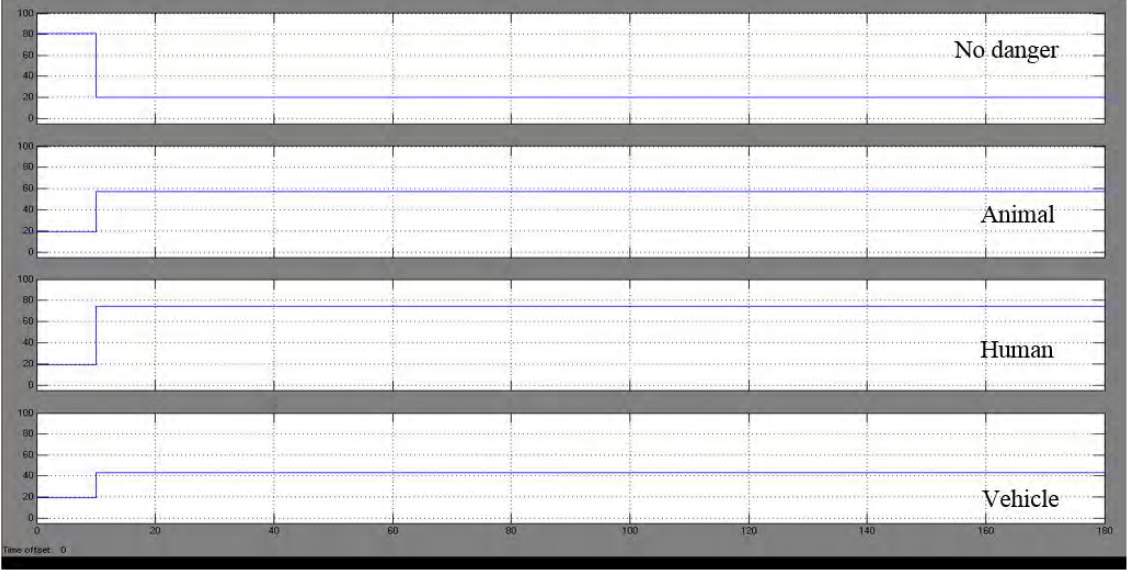
Figure 12. The corresponding outputs of the three inputs(3.5, 2.5 and 1.5)